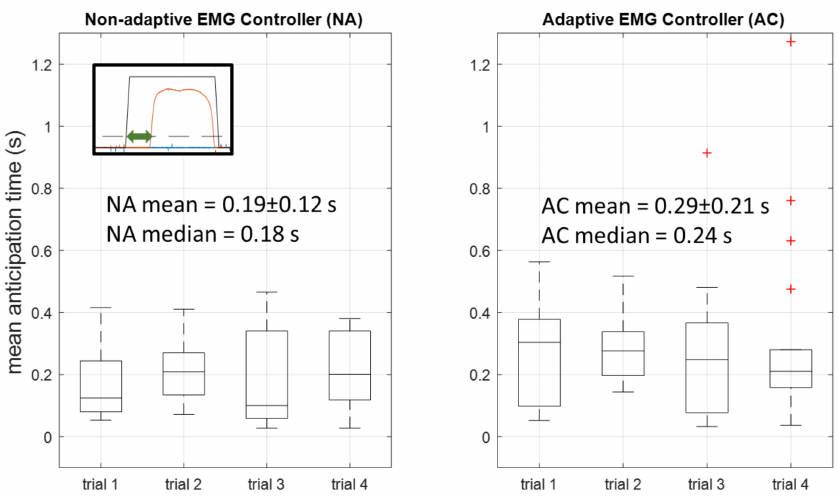
Figure 10. Mean and median anticipation time (seconds) of true positive grasps. Anticipation time for a given grasp is calculated as the time that the grasping pressure exceeds the trigger threshold minus the time that a grasp was triggered by the EMG controller, as shown by the green arrow on the inset